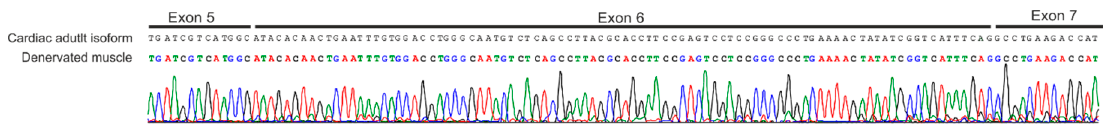
Figure 1. Comparison of exon 6 sequence between reference cardiac adult isoform (top sequence) and the sequence obtained from the denervated skeletal muscle (bottom sequence). The electropherogram corresponds to the product obtained for the denervated muscle.